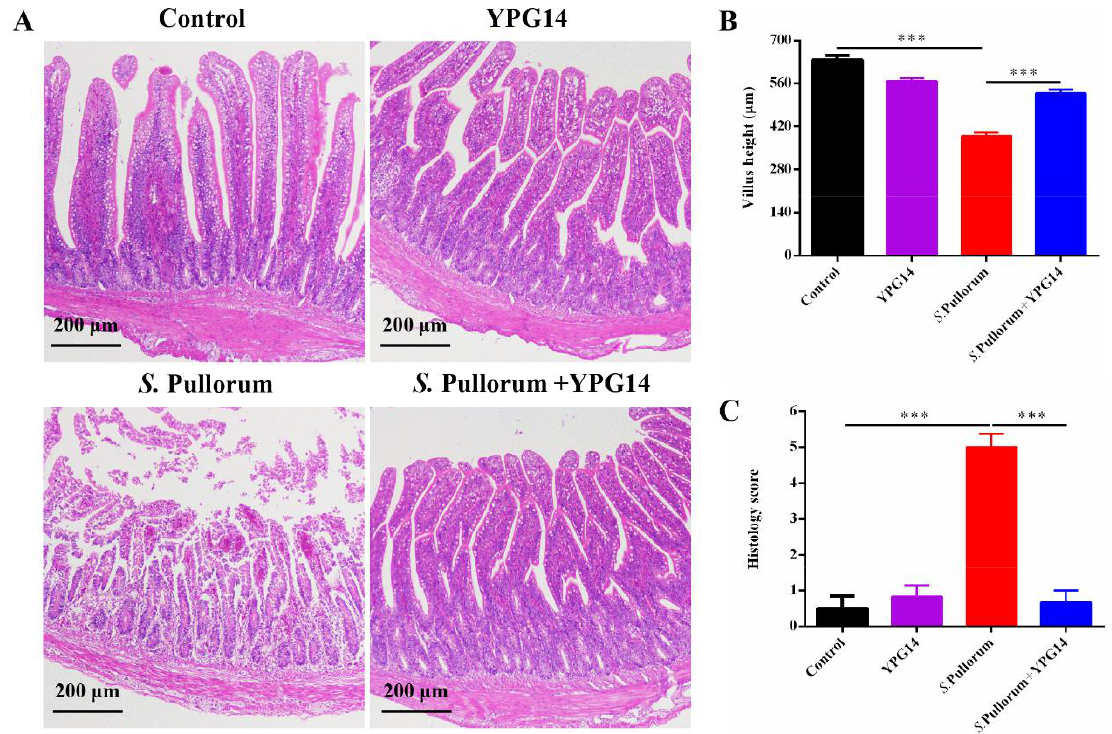
Figure 8. Histopathological changes of jejunum tissues. ( A ) Histopathological changes in jejunum tissues were examined by H&E staining (scale bar = 200 μm); ( B ) The determination of villus length of jejunum tissues (10 villi per histology section); ( C ) The histological score of jejunum tissues. All data are shown as mean ± SEM. Student’s t -test was performed. Statistical significance is indicated by *** p < 0.001.